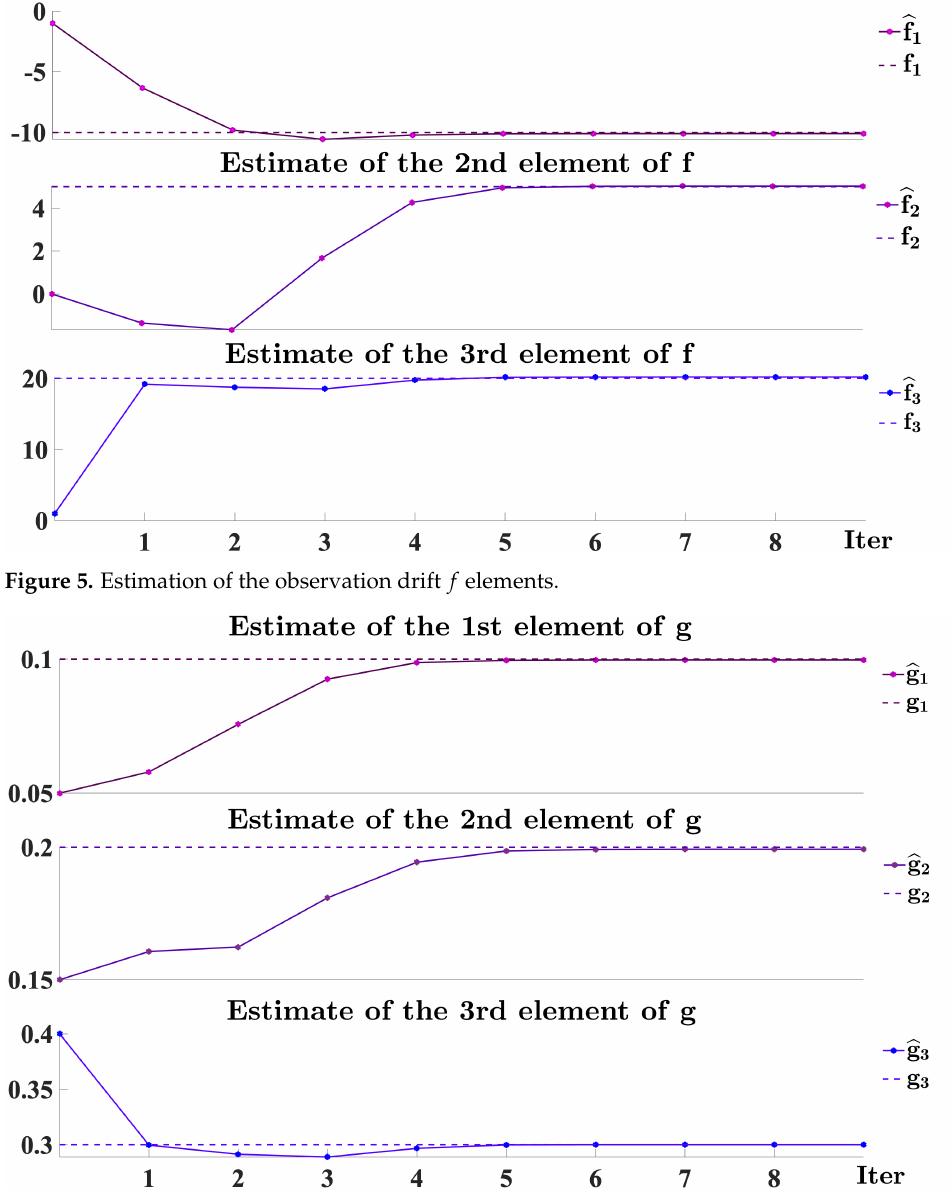
Figure 6. Estimation of the observation diffusion g